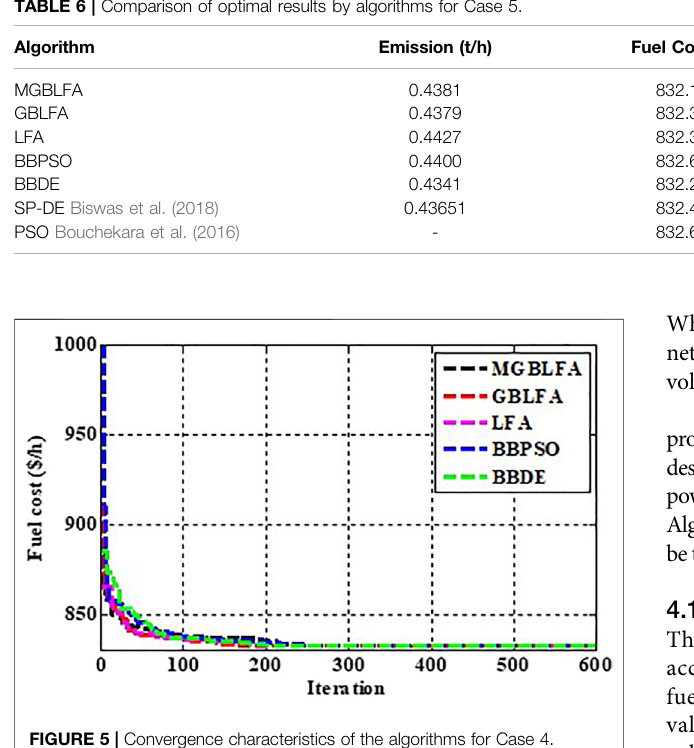
FIGURE 5 | Convergence characteristics of the algorithms for Case 4.